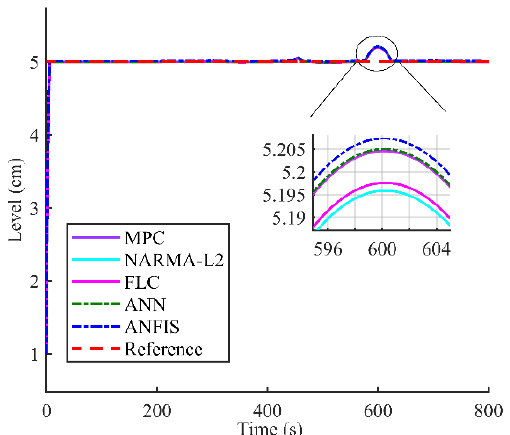
Figure 17. Result of liquid level control in the spherical tank under a disturbance at the system input.